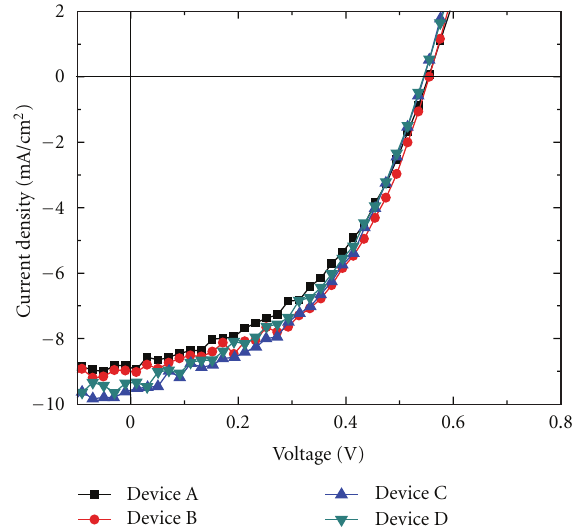
Figure 5: The I-V characteristics of devices with di ff erent con- centrations of MWCNTs. Device A: pristine PEDOT:PSS film; Device B: M (0.04wt%)-PEDOT:PSS film; Device C: M (0.10wt%)- PEDOT:PSS film; Device D: M(0.20wt%)-PEDOT:PSS